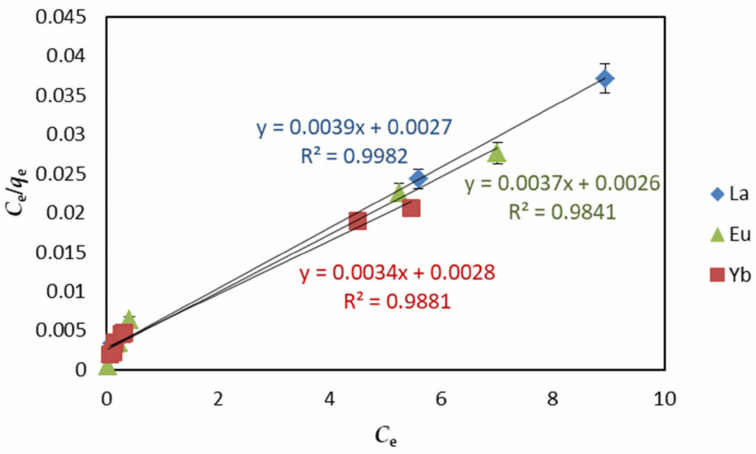
Figure 11. Langmuir isotherms of REEs adsorption on EDTA–CS@ZIF-8.